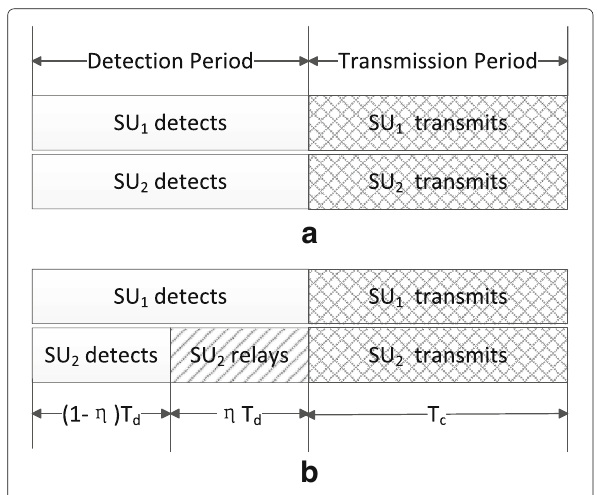
Fig. 2 a Non-cooperation, and b partial relay-based cooperation